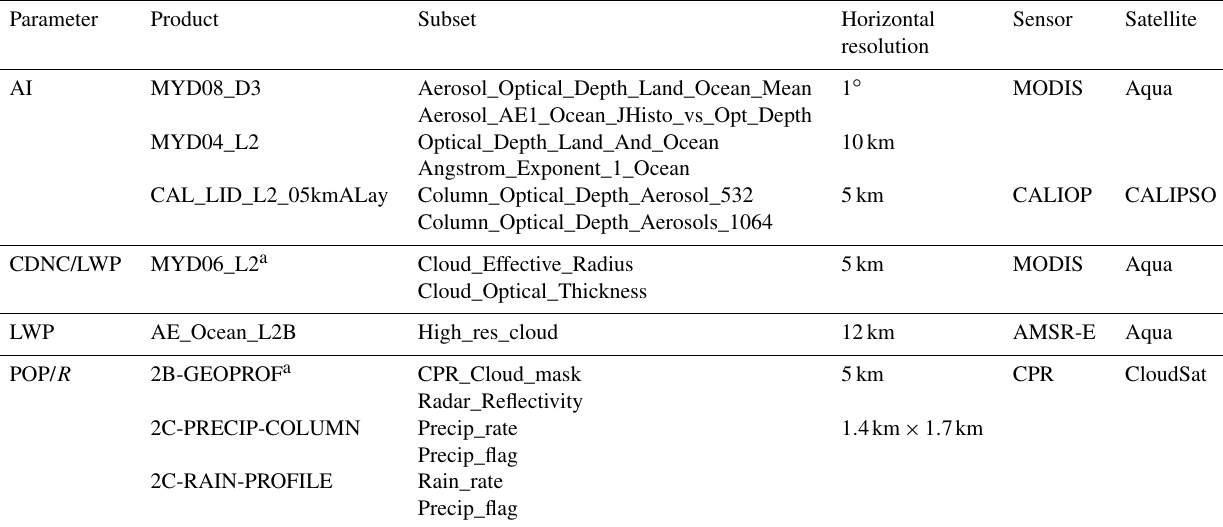
Table 2. Satellite products employed to estimate aerosol and cloud properties in this